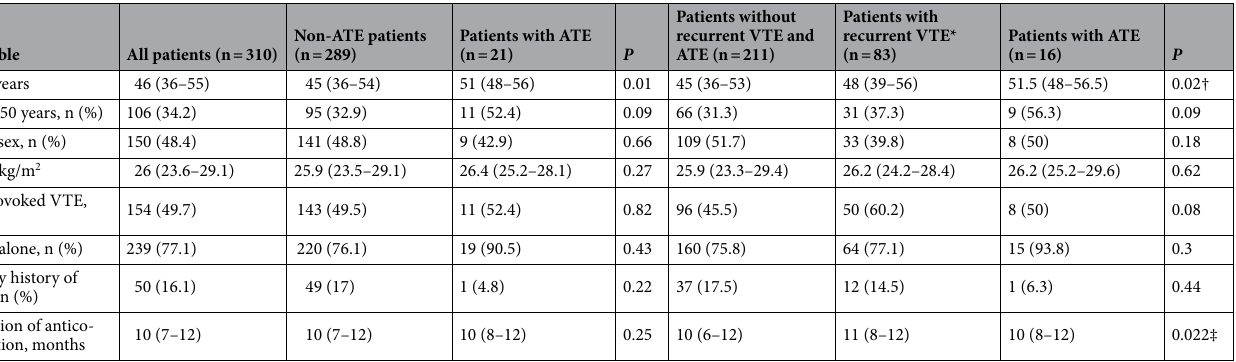
Table 1. Baseline characteristics of patients divided into groups based on the occurrence of venous thromboembolism (VTE) or arterial thromboembolism (ATE) during follow-up. BMI body mass index, DVT deep vein thrombosis. Values are given as median (interquartile range), or numbers (percentages). In terms of ATE two patients excluded from the previous analysis were included in the current follow-up study.* Five patients with both recurrent VTE and ATE were included into recurrent VTE group as this event occurred first. † Indicates statistical difference between patients without both VTE and ATE, and patients with ATE. ‡ Indicates statistical difference between patients without both VTE and ATE, and patients with recurrent